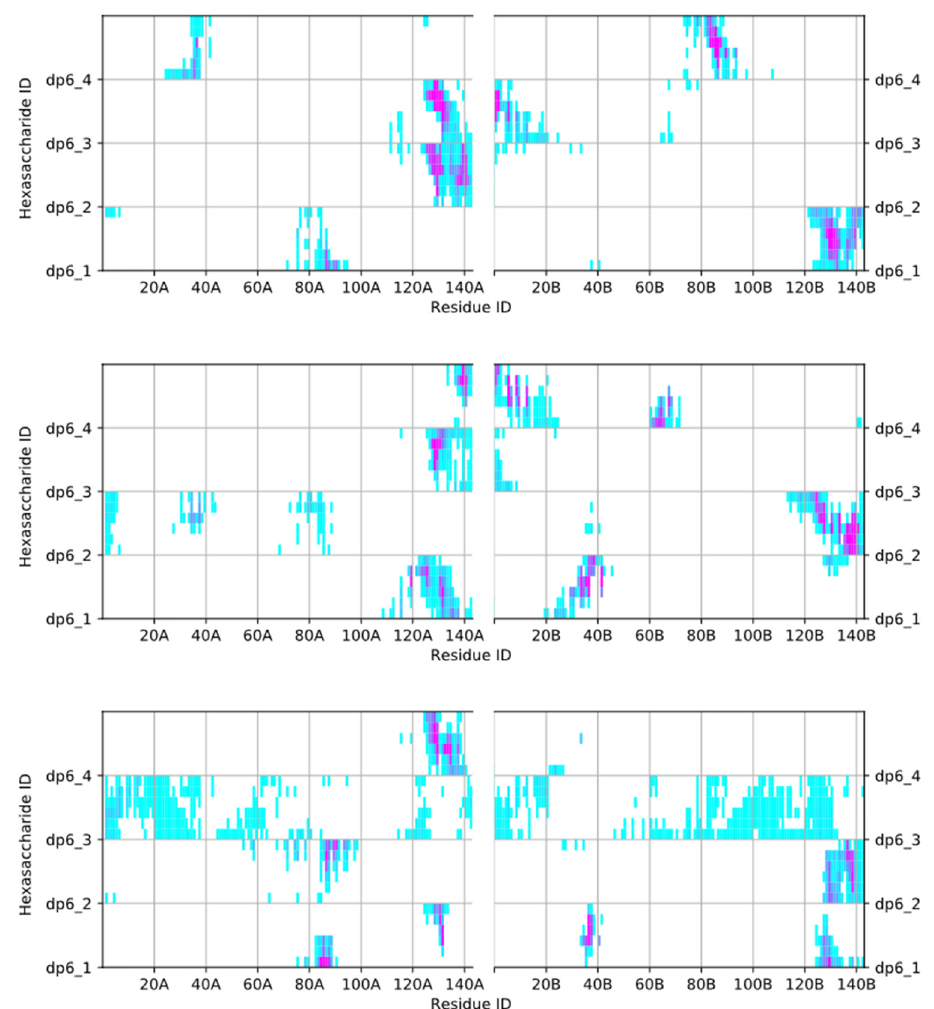
Figure 3. Contact map of the IFN γ /hexasaccharide complex. Contacts within 0.6 nm formed between each of the four hexasaccharides and the two monomers of IFN γ . Contact occupancy within the last 250 ns of the three simulations (upper, middle, and lower panels, resp.) ranges from 0 (cyan) to 1 (purple).